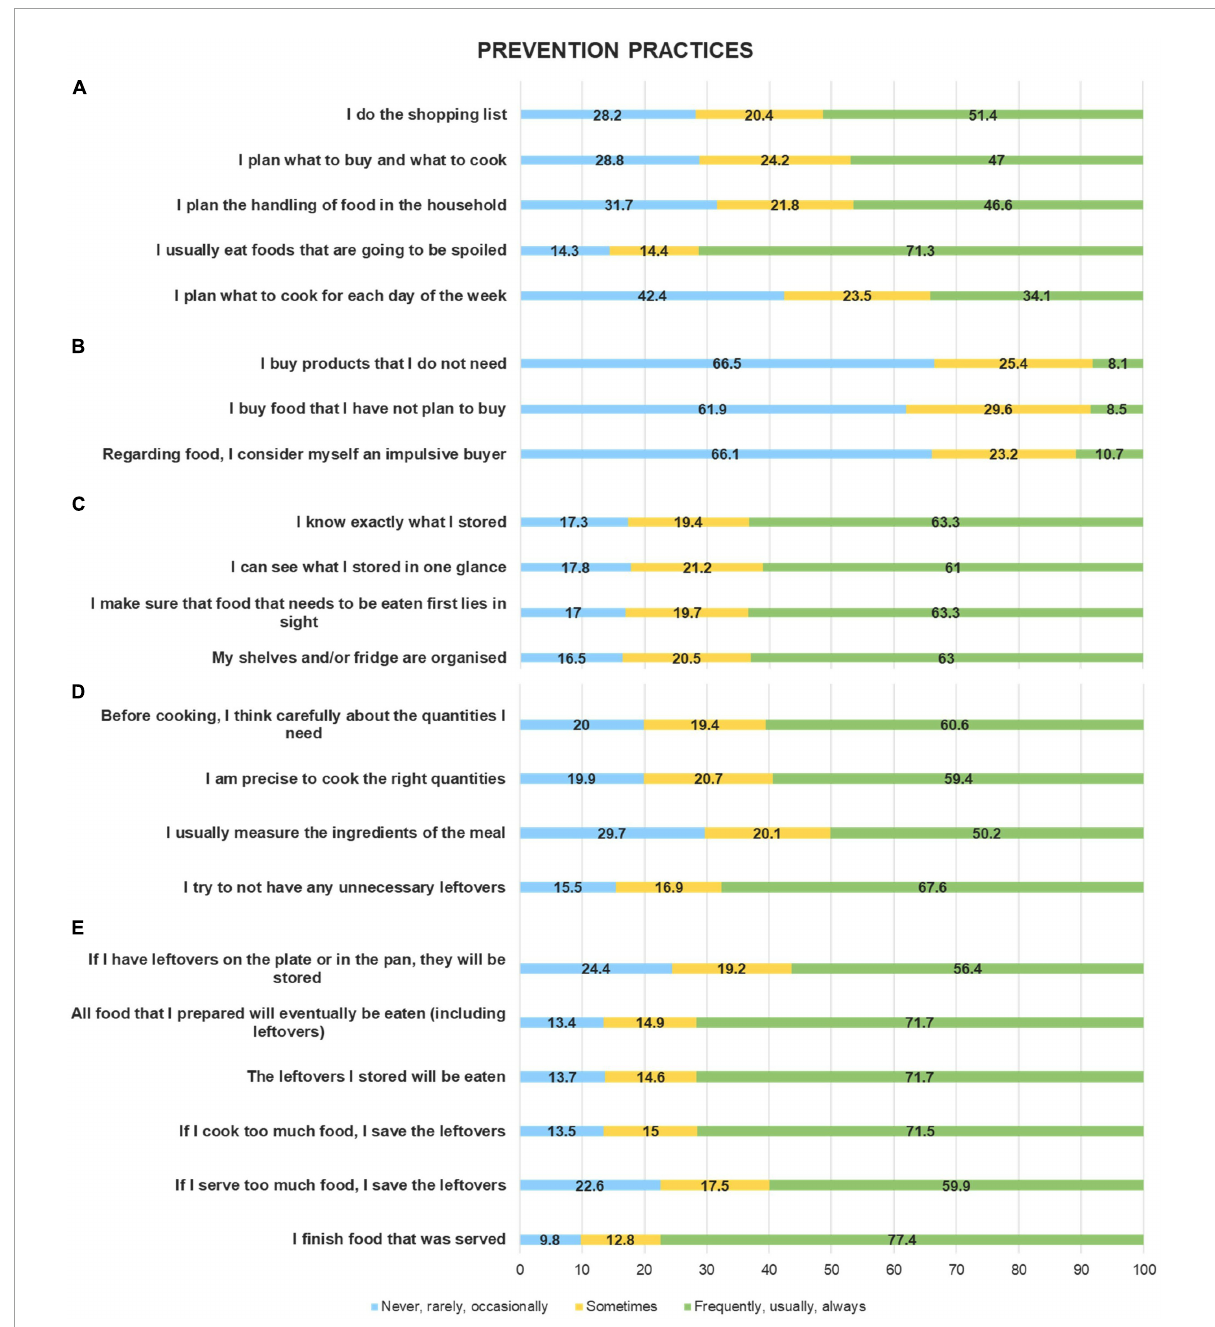
FIGURE1 Food waste prevention practices among the sample: planning the shopping and using the food (A) ; avoiding impulsive buying (B) ; the overview of stored food (C) ; cooking the right quantities of food (D) ; storing and using leftovers (E) . Percentage values (%).